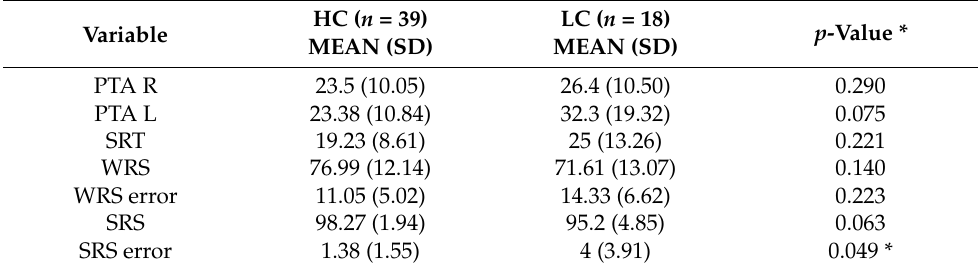
Table 4. Auditory examination variables of LC and HC.